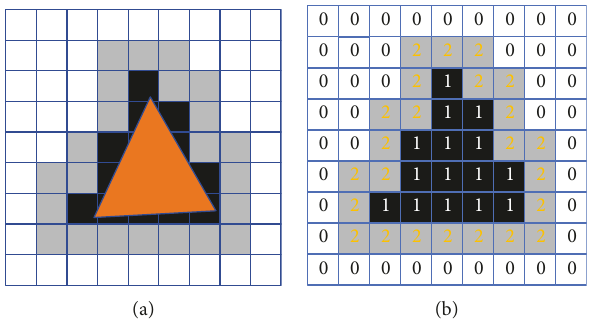
Figure 1: Improved grid method modeling. (a) Irregular obstacles. (b) Matrix